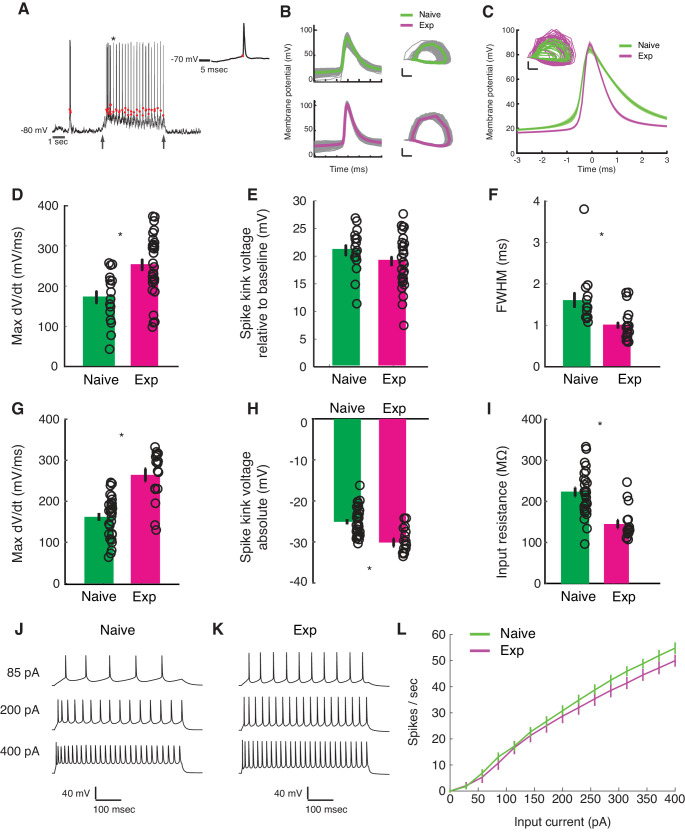
Developmental enhancement of excitability in cortical cells.(A) Detection of spike kink voltage from single action potentials in vivo (Azouz and Gray, 1999). (B) Action potentials and spike phase diagram from an example naive (top) and experienced cell (bottom). Individual spike traces shown in gray. In spike phase diagram, membrane potential is on the horizontal axis (scale bar is 20 mV) and dV/dt is on the vertical axis (scale bar is 100 mV/msec). (C) Average and standard error of the mean of voltage waveforms for naive (N = 14) and experienced (N = 29) cells, showing much wider action potentials in naive animals. Shaded area is standard error of the mean across cells. Inset: phase diagram of mean spike waveforms; membrane potential is on the horizontal axis (scale bar is 20 mV) and dV/dt is on the vertical axis (scale bar is 100 mV/msec). (D) Maximum dV/dt for naive and experienced cells in vivo (WRS test, p<2.0e-04); (E) spike kink voltages in vivo (WRS test, p=0.2); (F) action potential full width at half height (WRS test, p<4.3e-04) in vivo. (G) Maximum dV/dt for synaptically isolated cells in brain slices for naive and experienced animals. Ex vivo measurements showed similar maximum dV/dt values as in vivo measurements (N = 29 naive, N = 17 experienced, WRS, p<2.4e-05), showing similar values as in vivo measurements. (H) Spike kink voltage exhibited a significant decrease when measured in isolated cells from visually experienced animals (WRS p<1.6e-04). (I) Spike kink reductions and increased maximum dV/dt co-occurred with developmentally typical decreases in membrane resistance (WRS, p<1.2e-04), suggesting that experienced cells would take longer to charge from rest even though they spike at lower voltages. Example firing rate vs. current curves for a cell from a naive (J) animal and an experienced (K) animal are shown, and average firing rate vs. current curves are shown (L). The increased excitability with age and the decreased input resistance produced firing rate vs. current relationships that were not different between the two cases: (Kruskal-Wallis test of slopes: p<0.068). For all panels, p-values as listed are before Bonferroni correction; significant * indicates significant difference after Bonferroni correction (which did not change results for these tests).